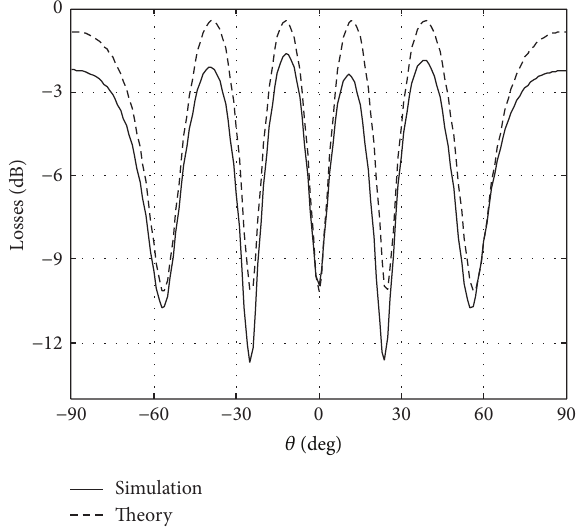
Figure 8: Losses as a function of the plane wave incidence angle in a 4 × 8 Nolen matrix operating in the receiving mode.